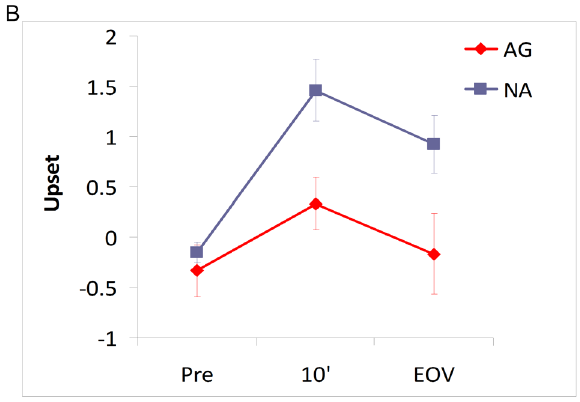
Figure 3. Time-course of emotional reactivity. Self-report of being Upset immediately before, during, and at the end (EOV) of the violent media viewing. Standard error is presented in the corresponding error bars.